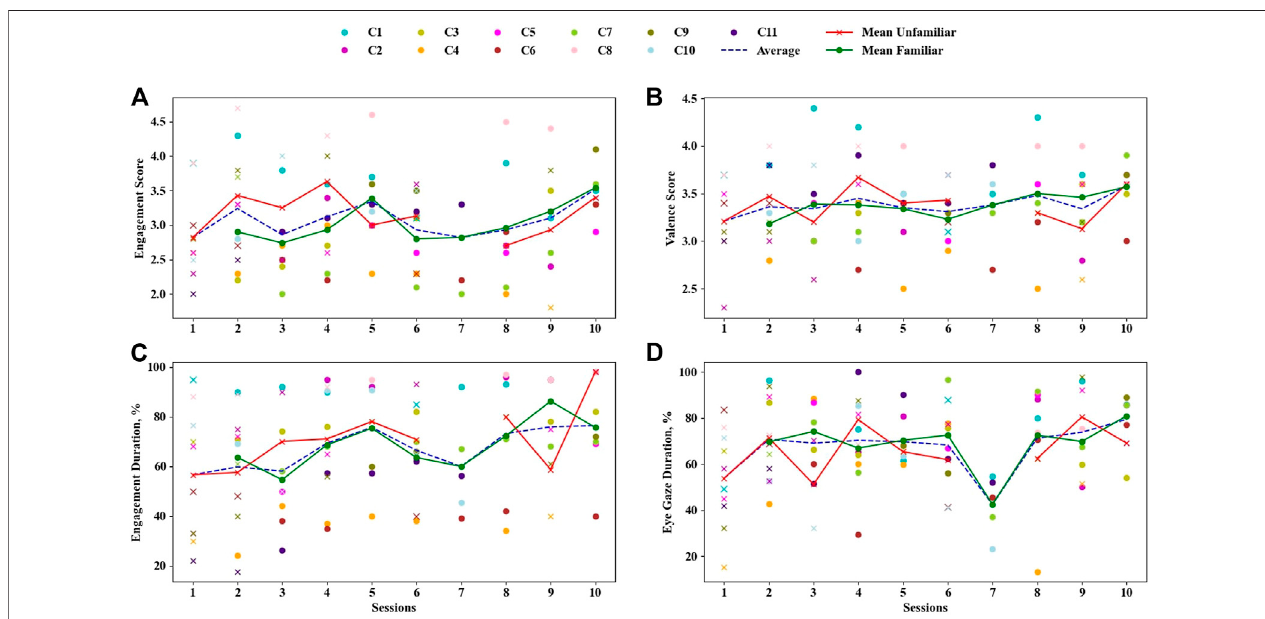
FIGURE 2 | Engagement and valence scores, engagement, and eye gaze durations for each child on each session. Familiar sessions are labelled with circle and unfamiliar sessions are labelled with cross (x) sign. Each colour represents a child.